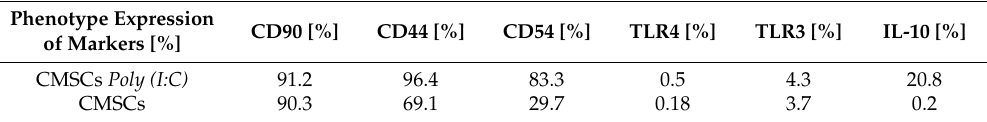
Figure 9. Phenotype expression markers co-cultured chorionic mesenchymal stem cells activated with polyinosine: polycytidylic acid CMSCs Poly (I:C) and CMSCs by paired t-test showed di ff erences in the groups CD54 (%) ( p = 0.0000), CD44 (%) ( p = 0.0006), and IL-10 (%) ( p = 0.0000); di ff erences were not confirmed in the CD90 (%) ( p = 0.8662), TLR3 (%) ( p = 0.375200) and TLR4 (%) ( p = 0.0925) groups, t-test. Histograms represent mean ± S.E of seven independent experiments. TLR = Toll-like receptor. Table 1. Significant di ff erences of CD44, CD54, and IL-10 between phenotype markers in co-cultured CMSC Poly (I:C) and